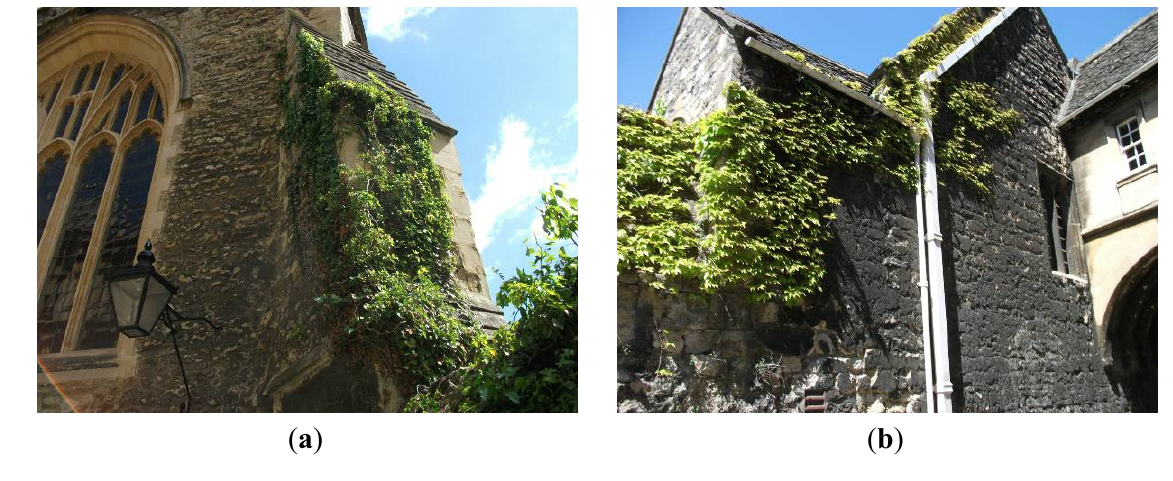
Figure 4. Climbing plants (climbers) along the lane, including ( a ) ivy at St Edmund Hall; ( b ) creeper in the grounds of Queen’s College and ( c ) ivy at New